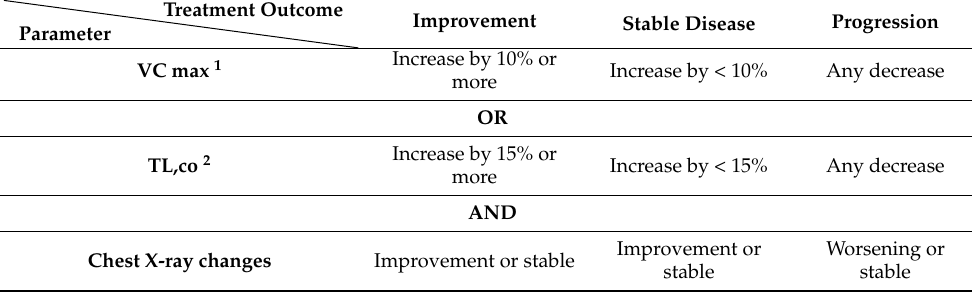
Table 1. Treatment outcome based on a combination of PFTs ad X-ray